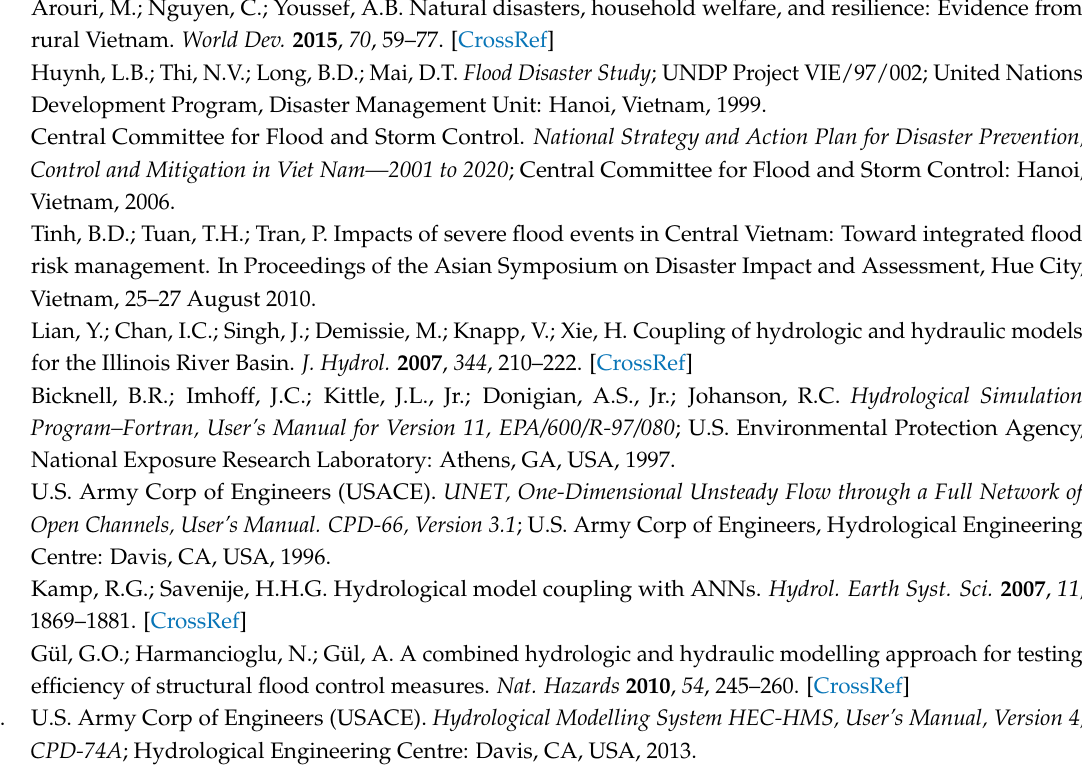
between simulated and observed flow for the 2006 flood season at the Thuong Nhat gauging station at the Ta Trach river: (a) observed and simulated 6-hourly flow versus time; (b) scatter plot of observed versus simulated flow; (c) ranked observed and simulated flow, Figure S3: Comparison between simulated and observed flow for the 2007 flood season at the Thuong Nhat gauging station at the Ta Trach river: (a) observed and simulated 6-hourly flow versus time; (b) scatter plot of observed versus simulated flow; (c) ranked observed and simulated flow, Figure S4: Comparison between simulated and observed flow for the 2006 flood season at the Binh Dien gauging station at the Huu Trach River: (a) observed and simulated 6-hourly flow versus time; (b) scatter plot of observed versus simulated flow; (c) ranked observed and simulated flow, Figure S5: Comparison between simulated and observed flow for the 2007 flood season at the Binh Dien gauging station at the Huu Trach River: (a) observed and simulated 6-hourly flow versus time; (b) scatter plot of observed versus simulated flow; (c) ranked observed and simulated flow, Figure S6: Comparison between simulated and observed water surface level for the 2006 flood season at the Phu Oc gauging station at the Bo River: (a) observed and simulated 6-hourly water level versus time; (b) scatter plot of observed versus simulated water level; (c) ranked observed and simulated water level, Figure S7: Comparison between simulated and observed water surface level for the 2007 flood season at the Phu Oc gauging station at the Bo River: (a) observed and simulated 6-hourly water level versus time; (b) scatter plot of observed versus simulated water level; (c) ranked observed and simulated water level, Figure S8: Comparison between simulated and observed water surface level for the 2006 flood season at the Kim Long gauging station at the Huong River: (a) observed and simulated 6-hourly water level versus time; (b) scatter plot of observed versus simulated water level; (c) ranked observed and simulated water level, Figure S9: Comparison between simulated and observed water surface level for the 2007 flood season at the Kim Long gauging station at the Huong River: (a) observed and simulated 6-hourly water level versus time; (b) scatter plot of observed versus simulated water level; (c) ranked observed and simulated water